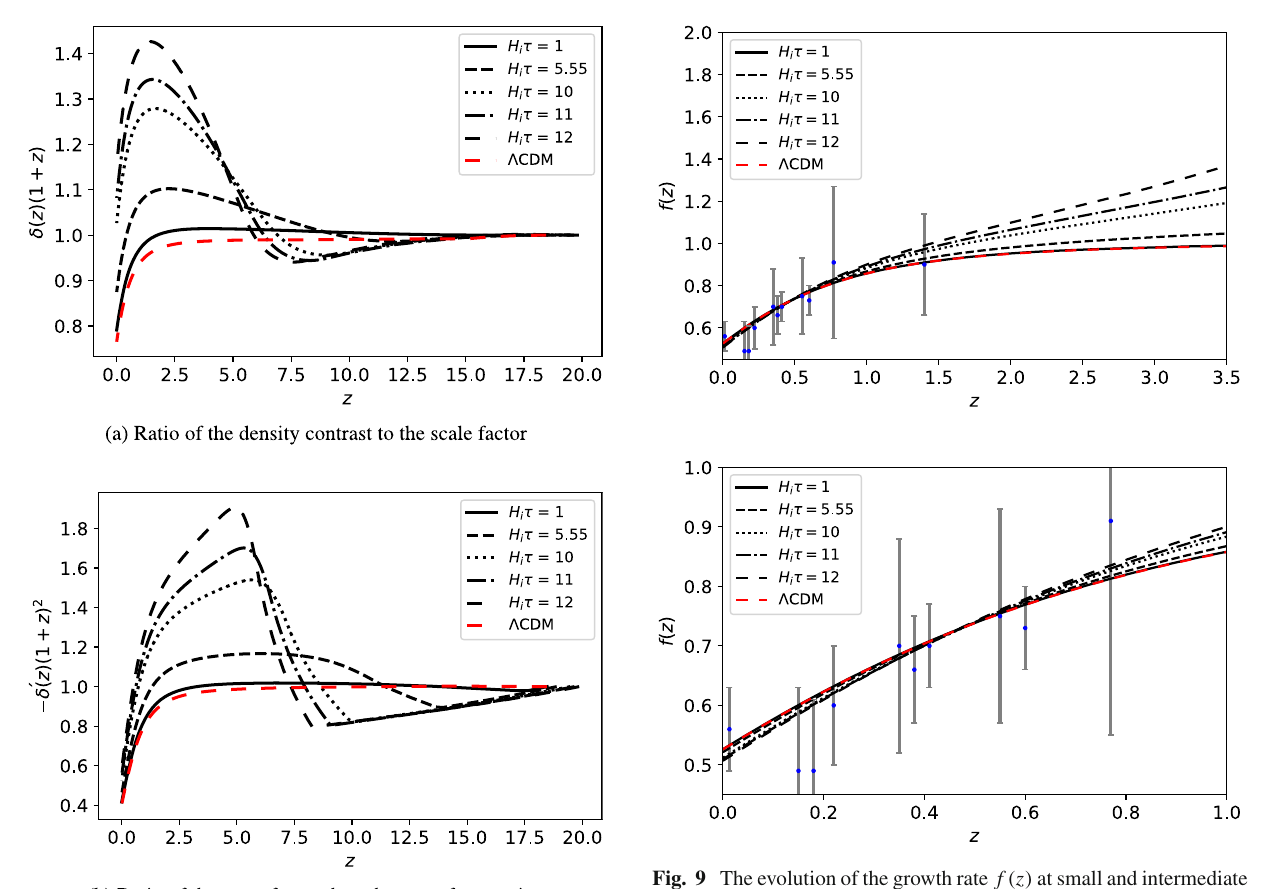
Fig. 9 The evolution of the growth rate f ( z ) at small and intermediate redshifts. The growth rate data are taken from the compilation in Ref.